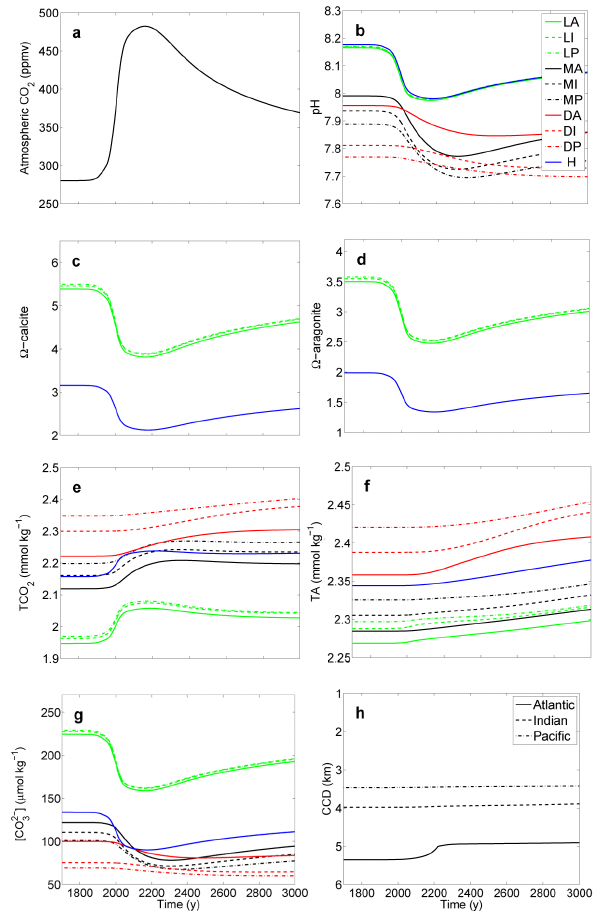
Fig. 6. Example of a fossil fuel emission scenario simulated in LOSCAR: total release of 1000PgC over 500yr (see Zeebe et al., 2008). Results shown slightly differ from those in Zeebe et al. (2008) because ocean temperature was held constant here for sim- plicity. L = Low-latitude, M = interMediate, D = Deep, H = High- latitude. A = Atlantic, I = Indian, P = Pacific. Note that the step in the Atlantic calcite compensation depth (CCD, panel h ) is due to the spacing of sediment-box depth levels in the model (adding more sediment boxes would make the curve